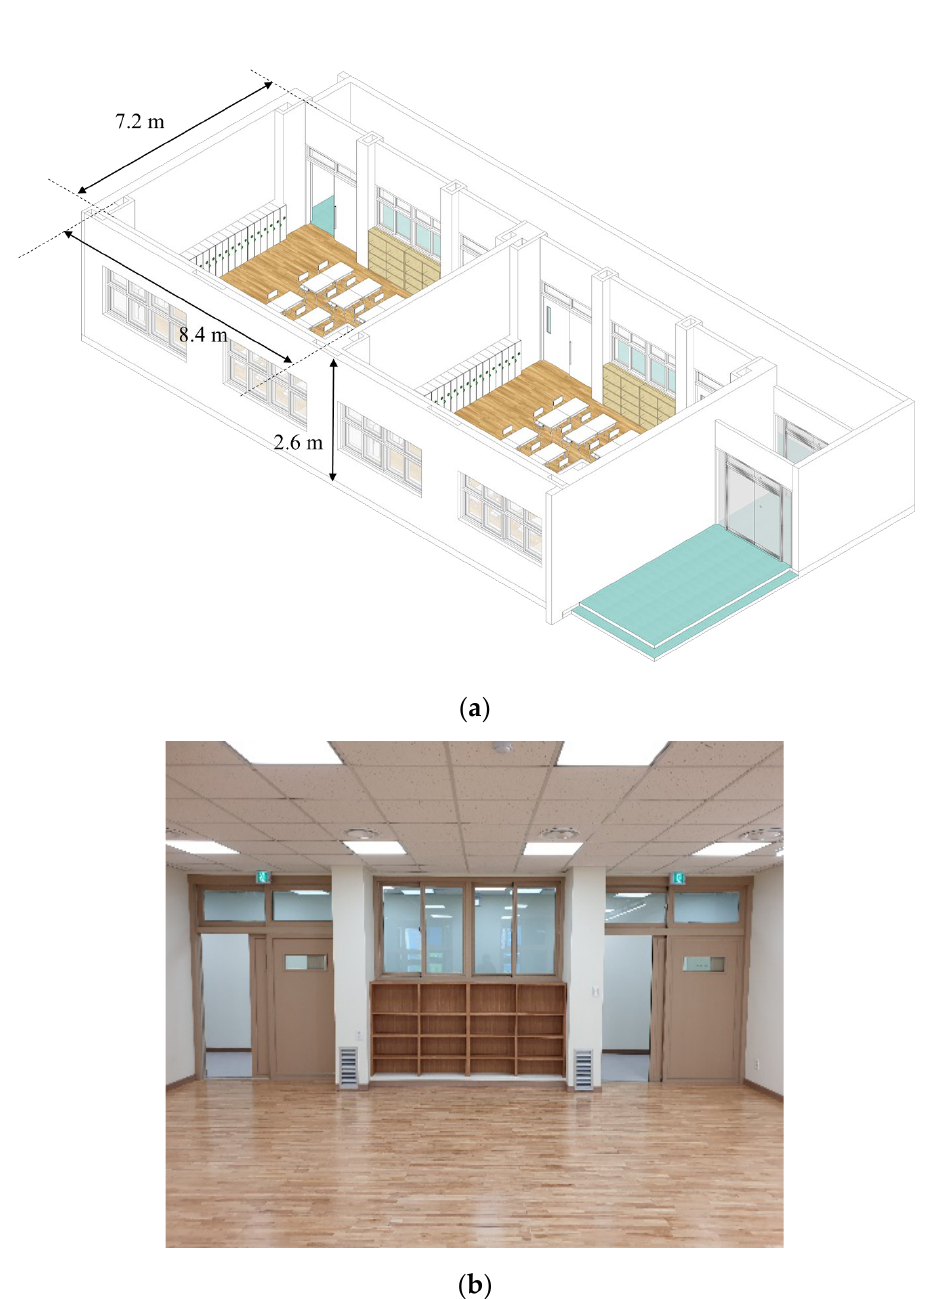
Figure 1. ( a ) Perspective view of the full-scale school environment performance test-bed. ( b ) Picture of a classroom.